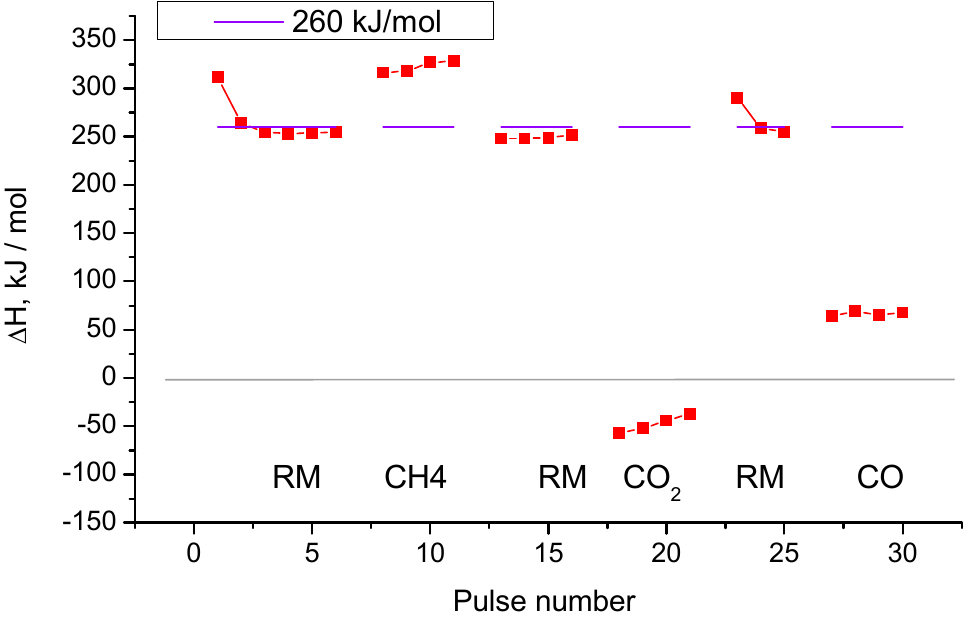
Figure 3. Measured heat effects during pulses of different compositions at 973 K.